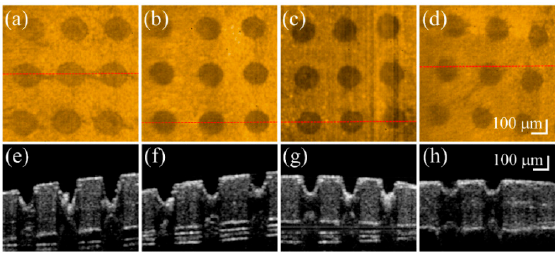
Figure 1. In vivo ( a – d ) top-view and ( e – h ) representative cross-sectional OCT images of four fingernails after fractional laser exposures to (from left to right) energies of 50, 40, 30, and 20 mJ. The red-dash lines in ( a – d ) indicate the corresponding locations of ( e – h ).